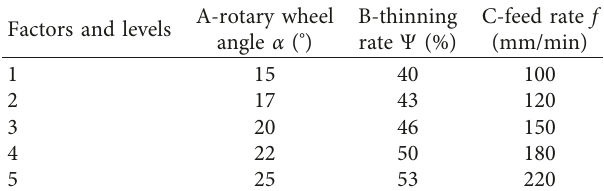
Table 3: Factors and levels in the orthogonal test.